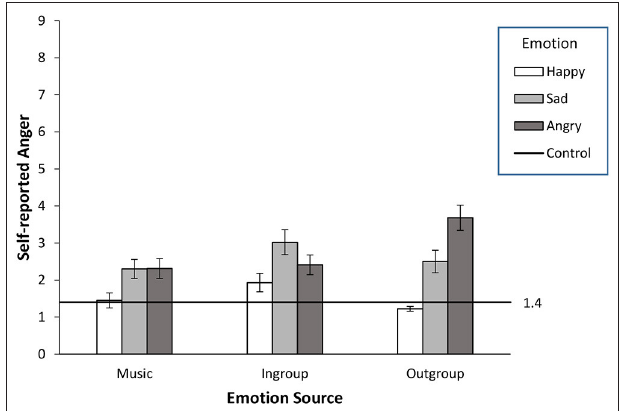
FIGURE 4 | Emotion manipulation checks for Experiment 2 on self-reported anger, as a function of manipulated emotion and emotion source (see main text for simpler patterns detected on self-reported happiness and sadness; N = 492 White Male